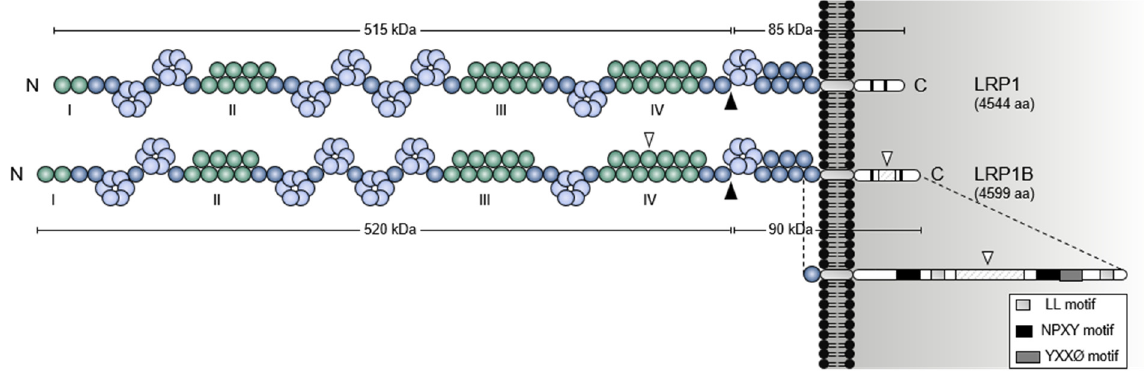
Figure 2. Domain organization comparison between human LRP1 and LRP1B. The four extracellular ligand-binding domains (I to IV) are shown. The two structural differences between LRP1 and LRP1B are indicated with white arrowheads: (i) an extra LDLRA domain in the fourth ligand-binding domain of LRP1B and (ii) a unique 33 amino acid sequence between the two NPXY motifs in the intracellular domain of LRP1B. The locations of the furin cleavage sites in the receptors are pointed out by black arrowheads. The intracellular domain of LRP1B is shown in more detail. Abbreviations: LL, dileucine; YXXØ, tyrosine-x-x-Ø (where X designates any amino acid and Ø an amino acid with a bulky hydrophobic